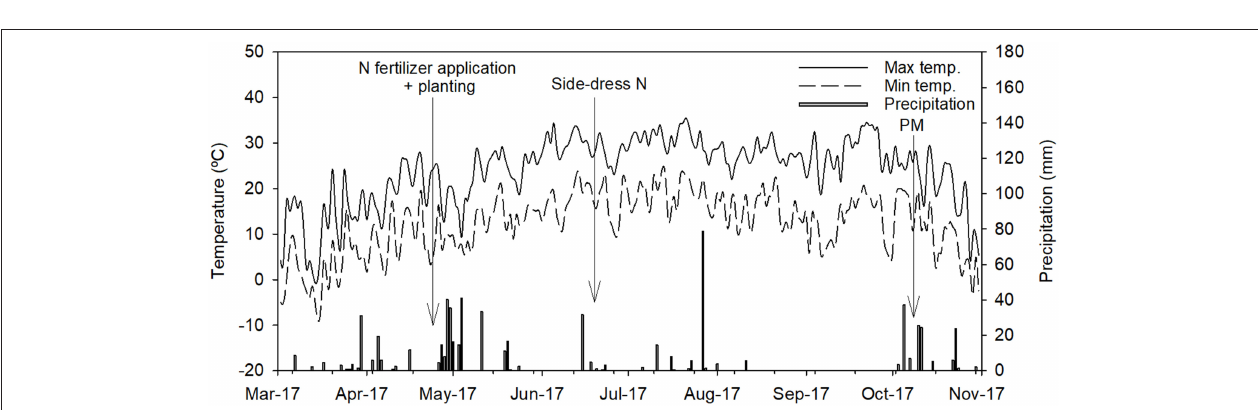
FIGURE 2 | Daily maximum and minimum air temperatures and precipitation during the corn growing season in 2017 at Dudley Smith Farm, Illinois, U.S. (N, nitrogen; PM, physiological maturity).